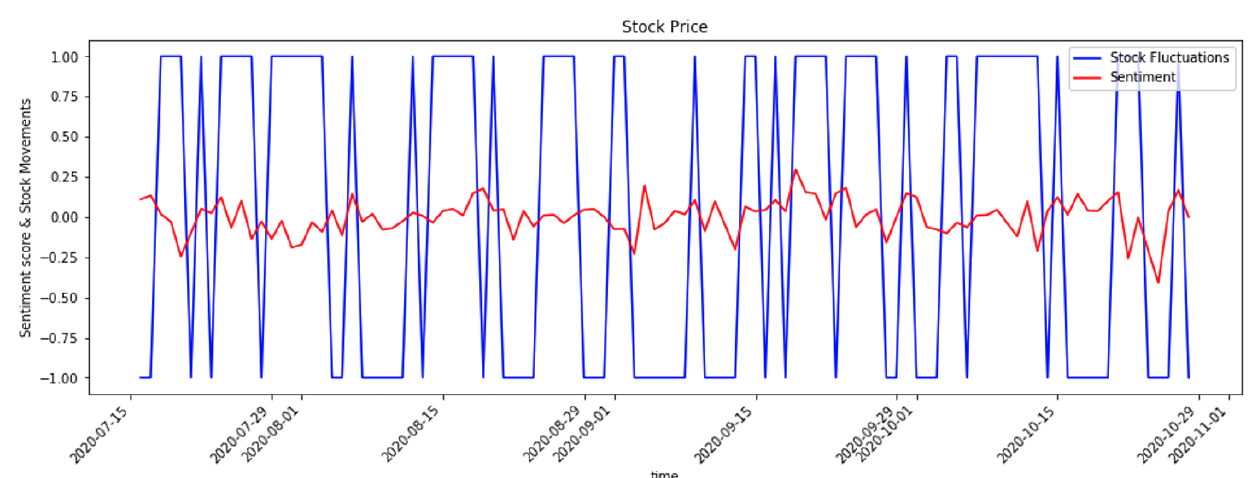
Figure 8. Sentiment & Stock Change for ‘Twitter with VADER’ data